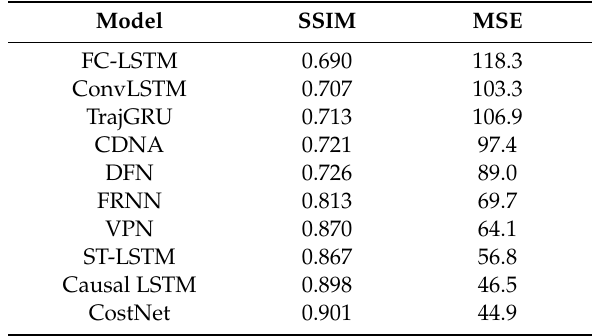
Table 1. A comparison of di ff erent models for predicting 10 frames on the Moving MNIST dataset.